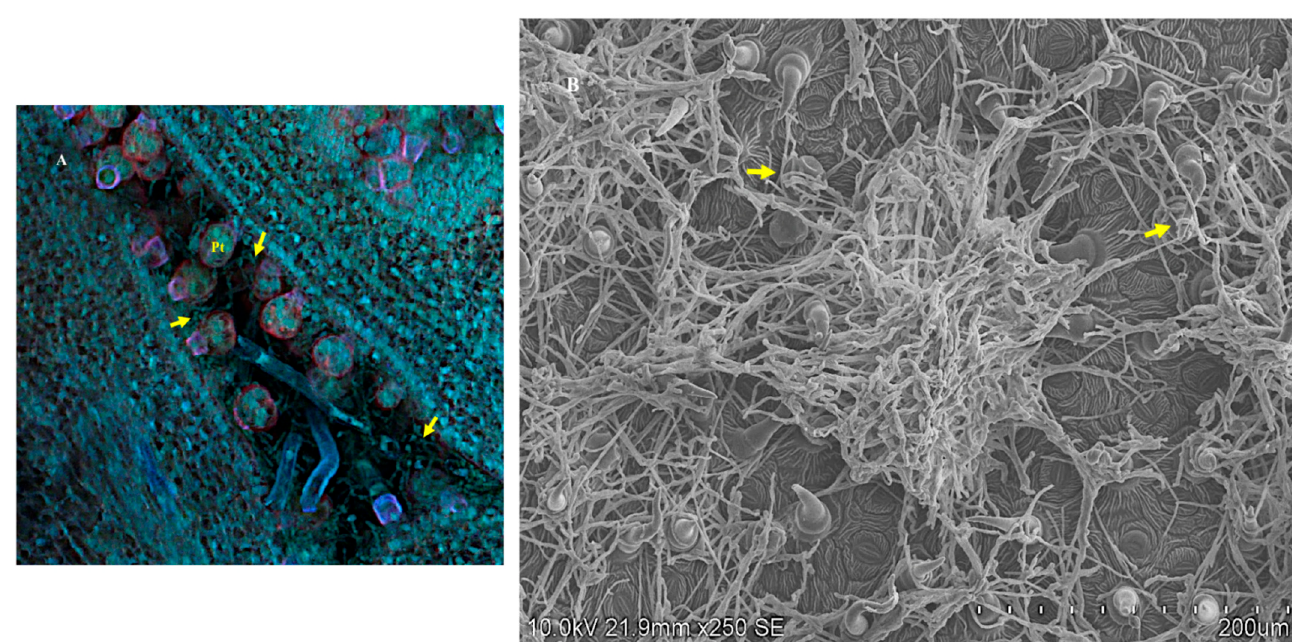
Figure 10. Fluorescent laser scanning confocal microscope of a longitudinal section of the adaxial surface of an I. carnea positive closed leaf from a mature plant ( A ) forming close contact with the peltate glandular trichomes (Pt) (scale bar—100 µ m). Scanning electron microscope showing topographical view of the mycelia on expanded leaf anchored to filiform trichomes and on top peltate gradual trichomes indicated by the arrows ( B ).